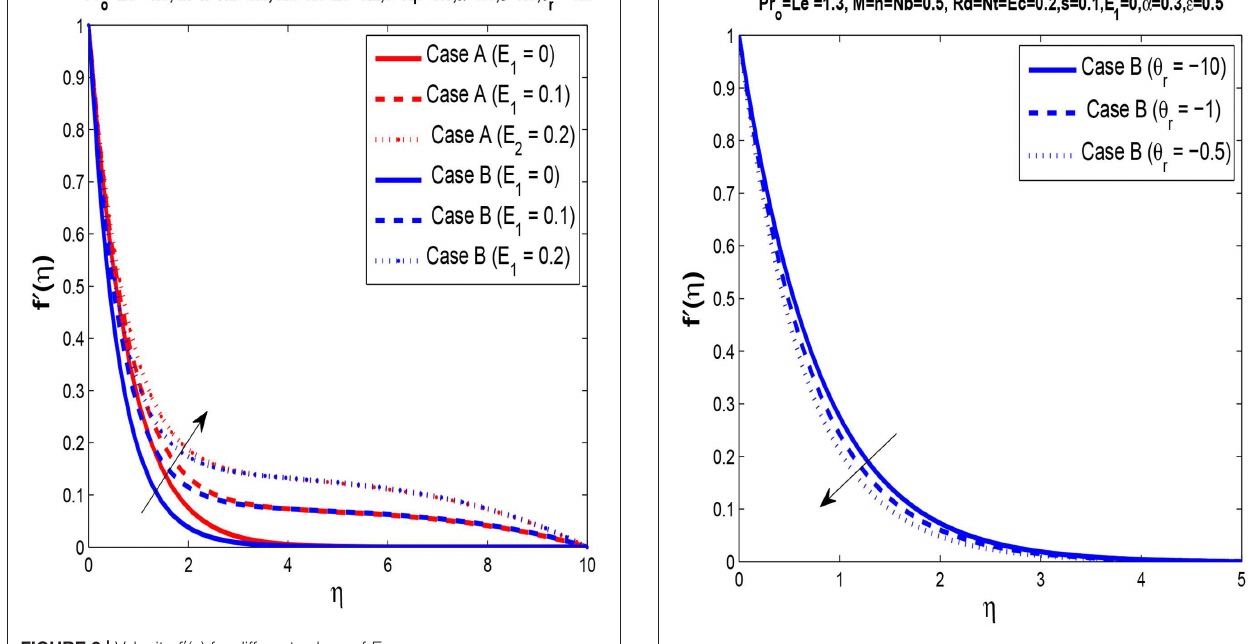
FIGURE 4 | Velocity profile f ′ ( η ) for different values of θ r .